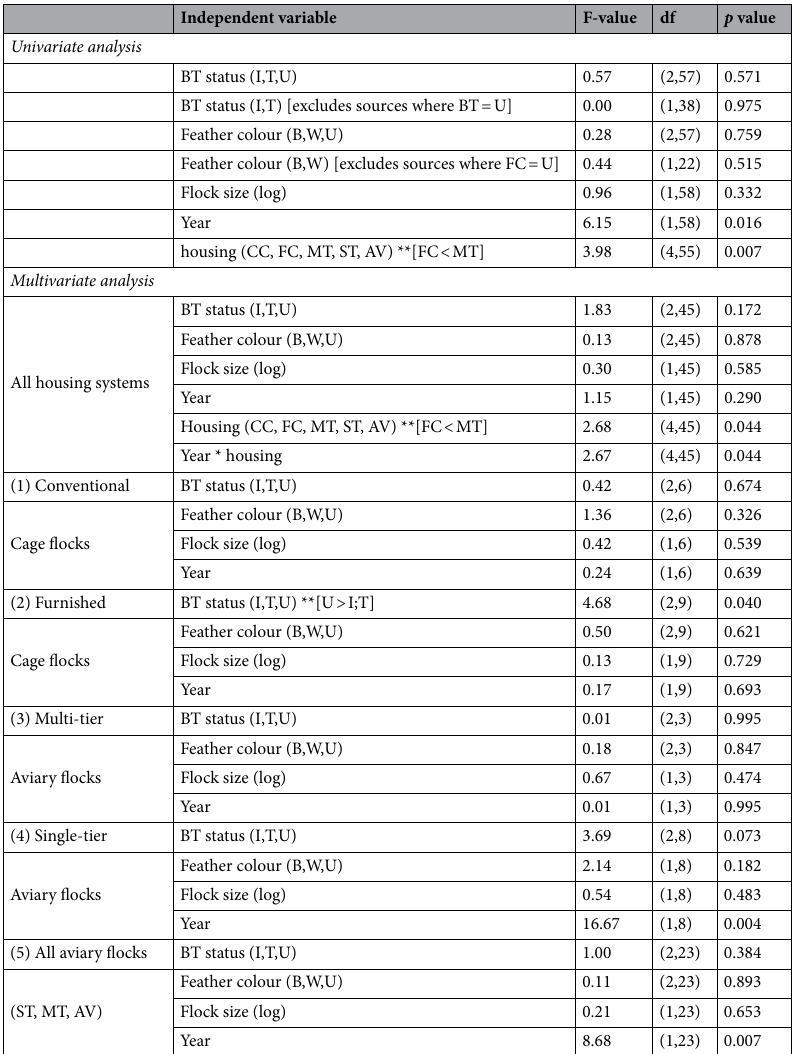
Table 2. Univariate and multivariate analyses on the effect of beak trimming (BT) status, feather colour, flock size, mid-year of data collection (year) and (indoor) housing system on cumulative layer mortality at 60 weeks (double arcsine transformed). I intact beaks, T trimmed beaks, W white hybrids, B brown hybrids, U unknown beak status or feather colour, CC conventional cages, FC furnished cages, MT multi-tier aviary flocks, ST single-tier aviary flocks, AV unspecified aviary type. **Tukey pairwise comparisons for categorical